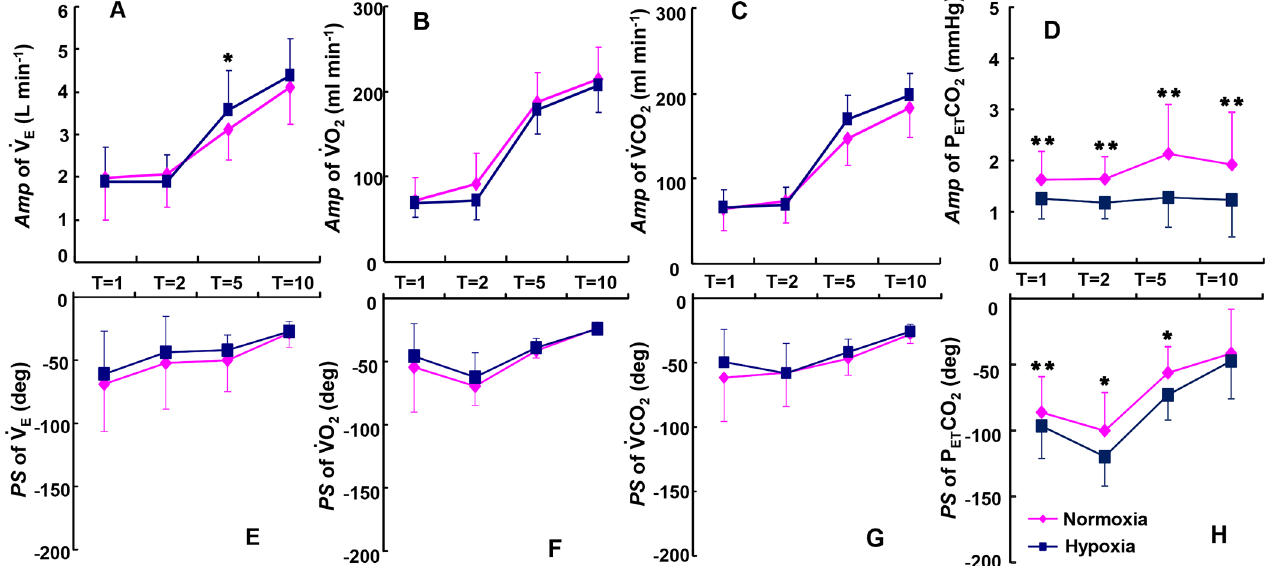
Fig 3. Comparison of Amp and PS of the kinetics between hypoxia and normoxia. Differences in the responses of Amp and PS of _ V _ VCO ( C,G ), and P ET CO 2 ( D,H ) between hypoxia (blue line) and normoxia (red line) as a function of the periods of the sinusoidal changes in the treadmill 2 speed are shown. (cid:3) p < 0.05, (cid:3)(cid:3) p < 0.01 for hypoxia vs. normoxia. Data are means ± SD.